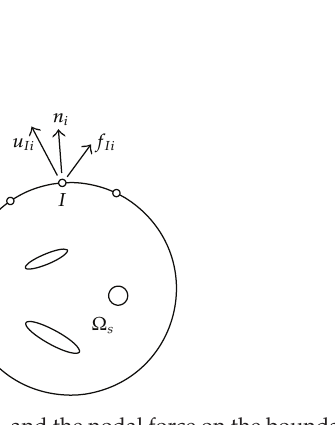
By comparing (cid:5) 3.9 (cid:6) to the general elastic constitutive relation, the macroscopic modulus tensor is given